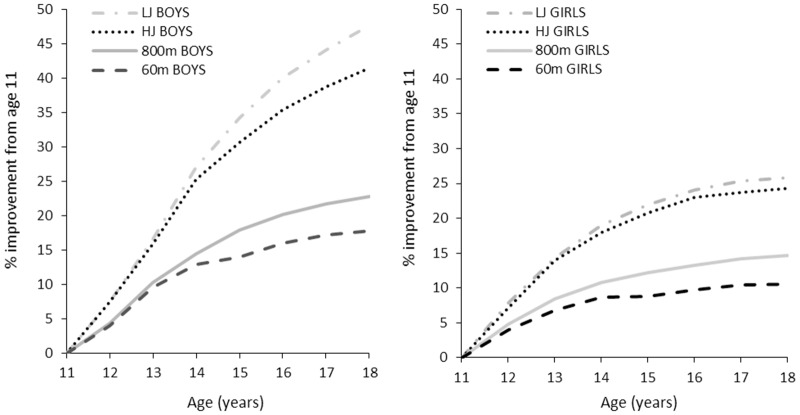
Percentage improvement in performance from age 11 to 18 in long jump, high jump, 60 m sprint and 800 m.Data are mean for top 100 Norwegian male (panel A) and female (panel B) performers in each discipline.